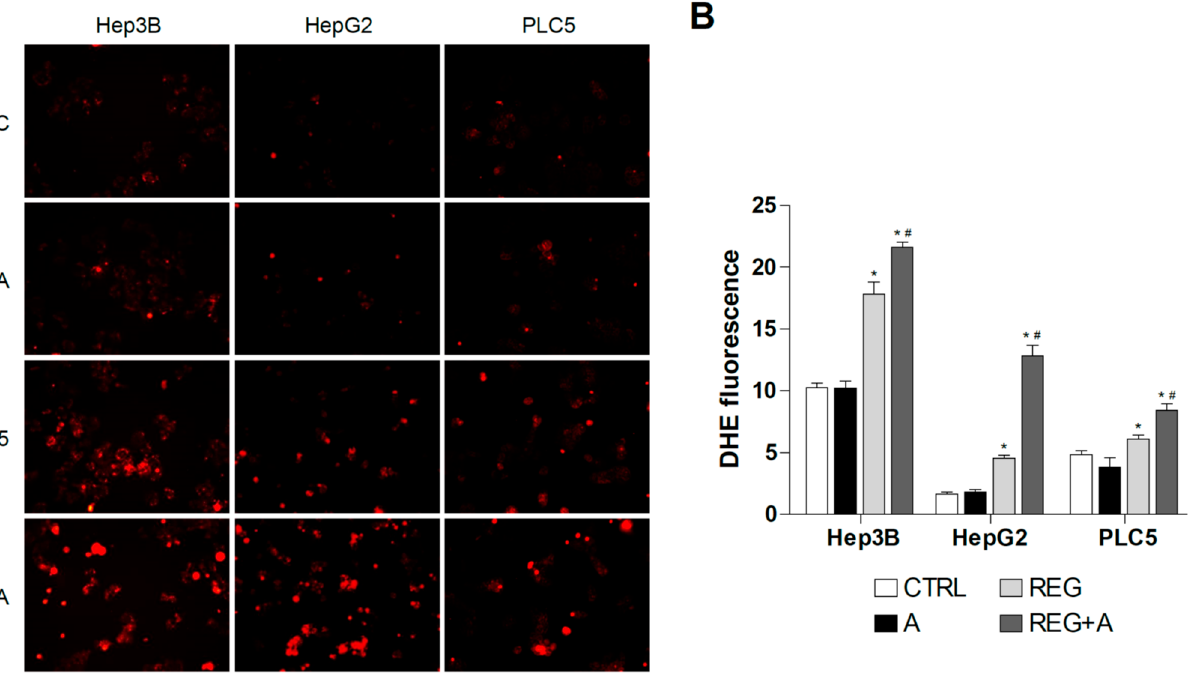
Figure 4. Superoxide production by regorafenib treatment was enhanced in liver cancer cell lines after co-administration with a BH3 mimetic. ( A ) Representative fluorescence images ( n = 10) of DHE (red) staining in HepG2, Hep3B and PLC5 cells receiving regorafenib treatment (R, 5 µM) in combination with or without the BCL-xL inhibitor A-1331852 (A, 0.1 µM) for 4 h. ( B ) Quantification of DHE fluorescence in cells was measured using Image J software. ( n = 3). * p < 0.05 vs. control, # p < 0.05 vs. regorafenib-treated cells.